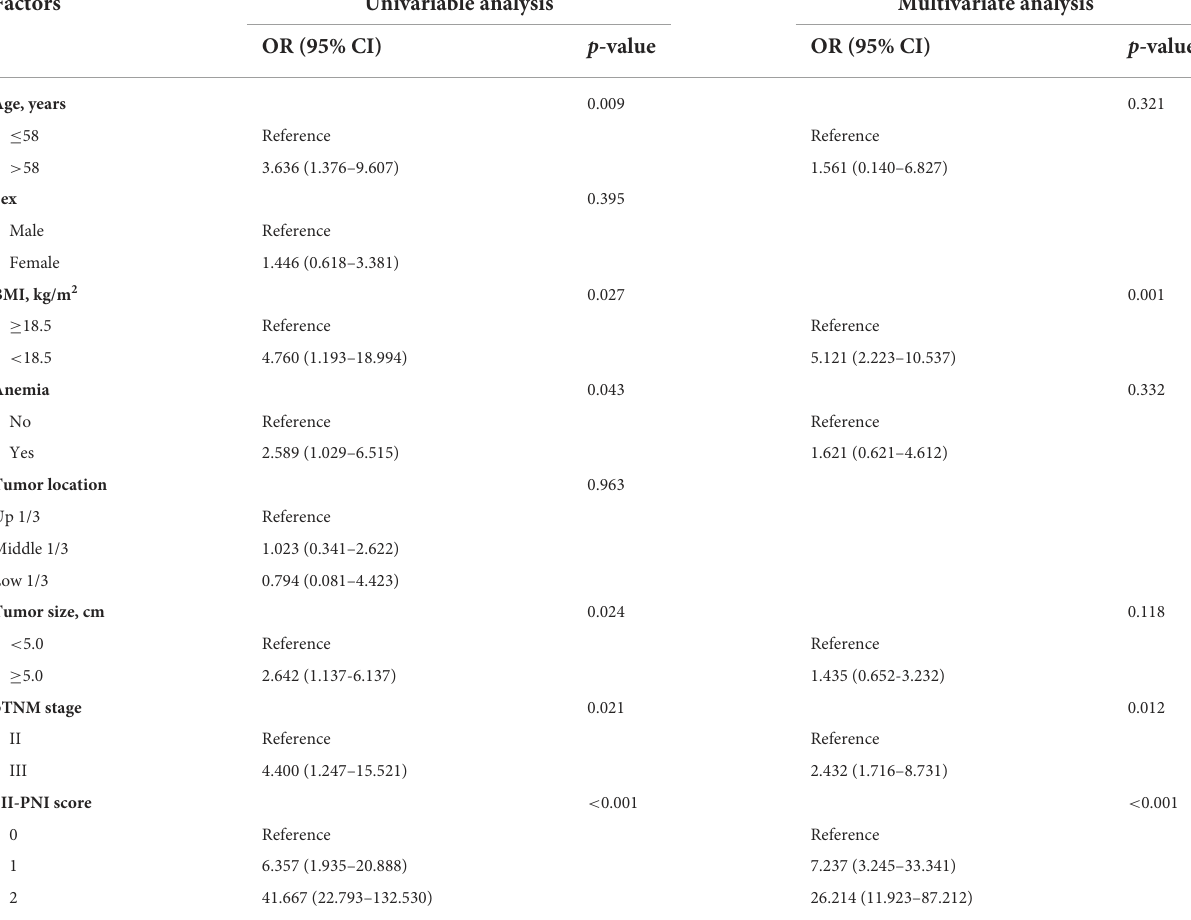
TABLE 2 Univariate and multivariate analyses the risk of